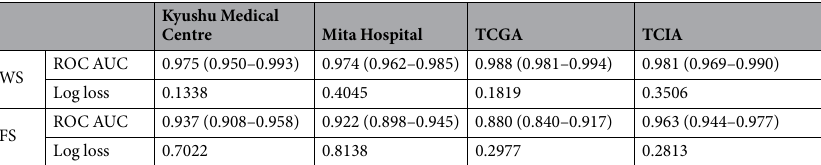
Table 1. Summary of ROC AUC and log loss results of the two training methods, fully-supervised (FS) and weakly-supervised (WS), on the 4 independent test sets: Kyushu Medical Centre, Mita Hospital, TCGA, and TCIA. The values between parenthesis indicate the 95% Confidence Intervals